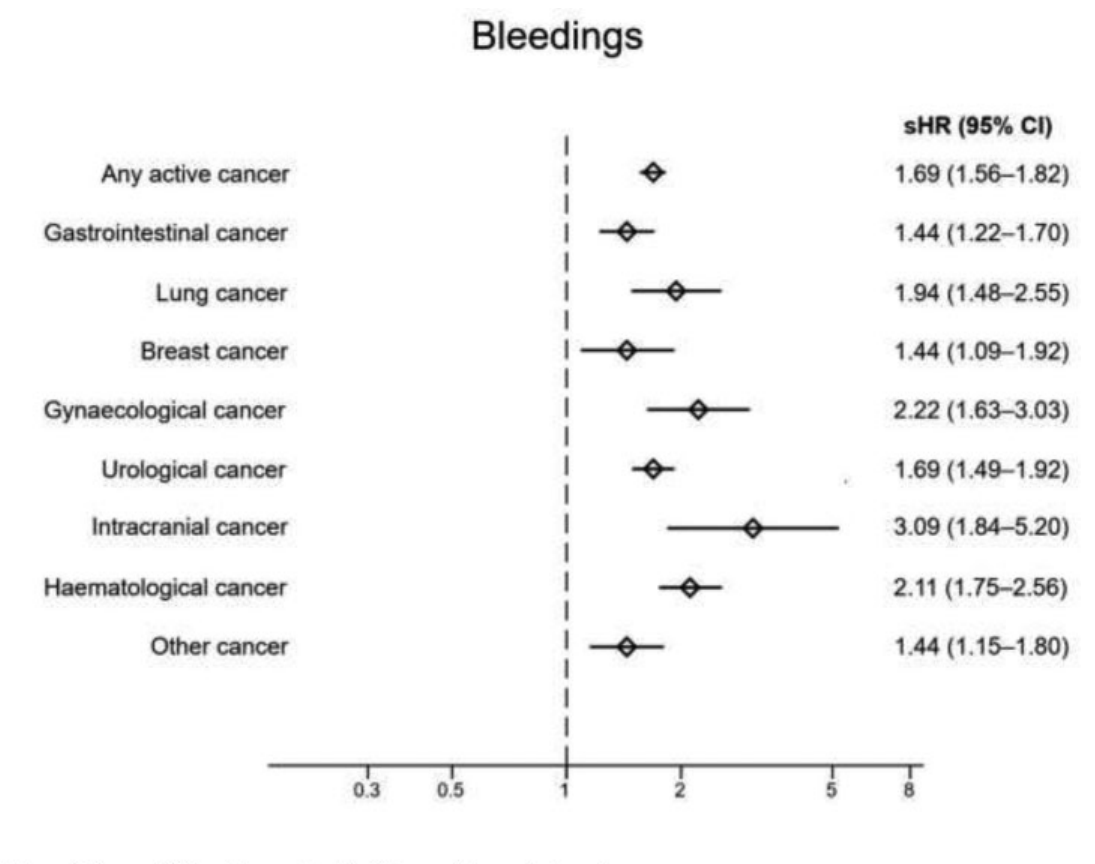
Fig. 3 Adjusted risks for all bleedings during the year following OAC initiation in patients with AF: cancer versus noncancer patients, accounting for the competing risk of death. AF, atrial fi brillation; OAC, oral anticoagulant.